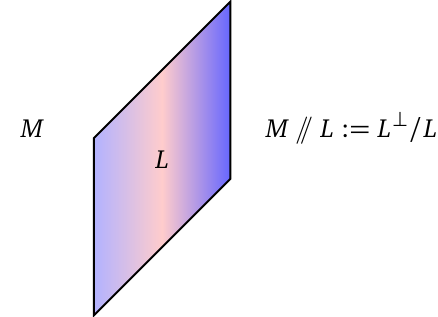
Figure 2: The wall is braided fusion 2-category with objects in L ⊥ , separating the original theory A from the vacuum. Similar to the case of quantum Hamiltonian reductions, the wall is a bimodule for the two categories on either